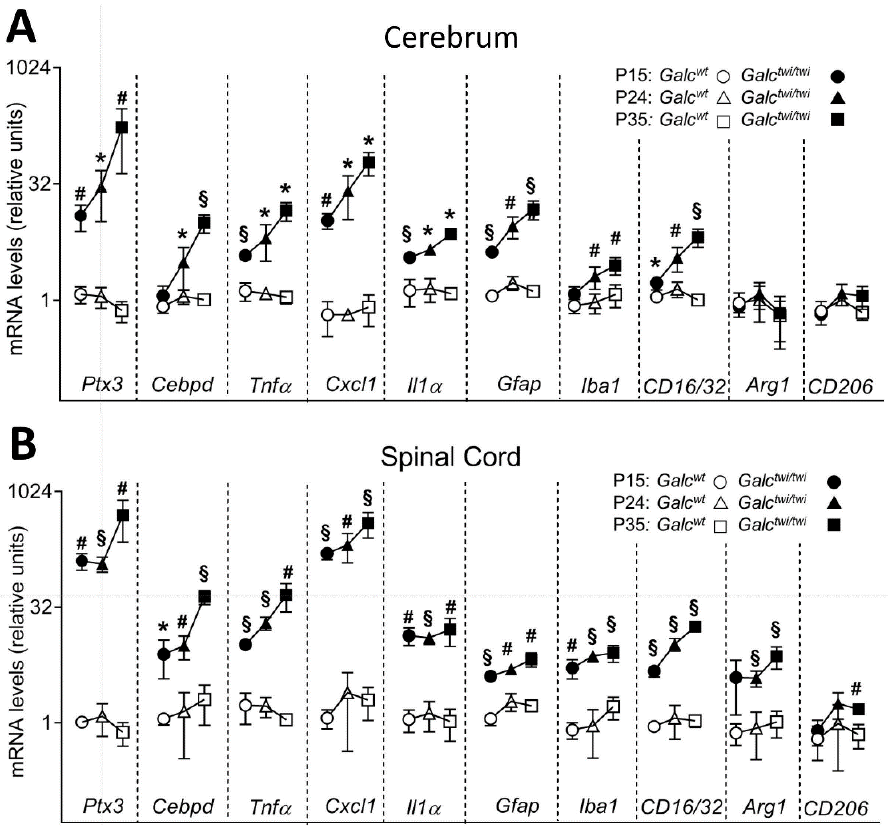
Figure 2. Ptx3 and proinflammatory gene expression in the cerebrum and spinal cord of twitcher mice. Steady state mRNA levels of the indicated genes were evaluated by qPCR in the cerebrum ( A ) and spinal cord ( B ) of Galc wt and Galc twi/twi mice harvested at P15, P24 and P35. Data were normalized to Gapdh expression and are the mean ± S.D. of 3 – 6 animals per group, * p < 0.05; # p < 0.01; § p < 0.001, Galc wt versus Galc twi/twi mice, Student’s t -test.